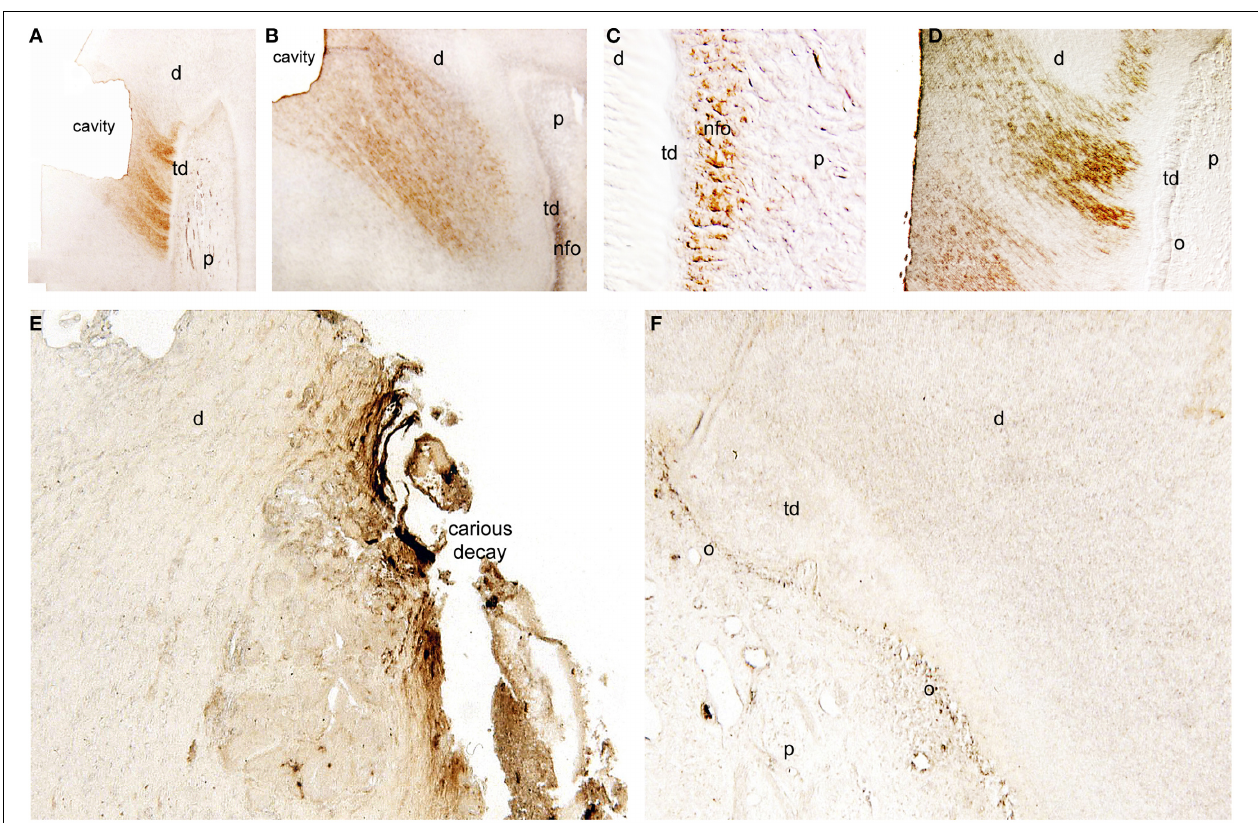
FIGURE 2 | Immunohistochemical localization of amelogenin in sections of injured and carious permanent human teeth. Cavitated (A–D) and carious (E,F) teeth. (A) Amelogenin staining in dentinal tubuli facing the class V cavity preparation 4 weeks post-operation. (B) Strong amelogenin labeling in newly-formed odontoblasts (nfo) that produce the tertiary dentin (td) 7 weeks post-injury. The staining is also detected in dentinal tubuli facing the injury site. (C) Higher magnification of the previous figure, showing amelogenin